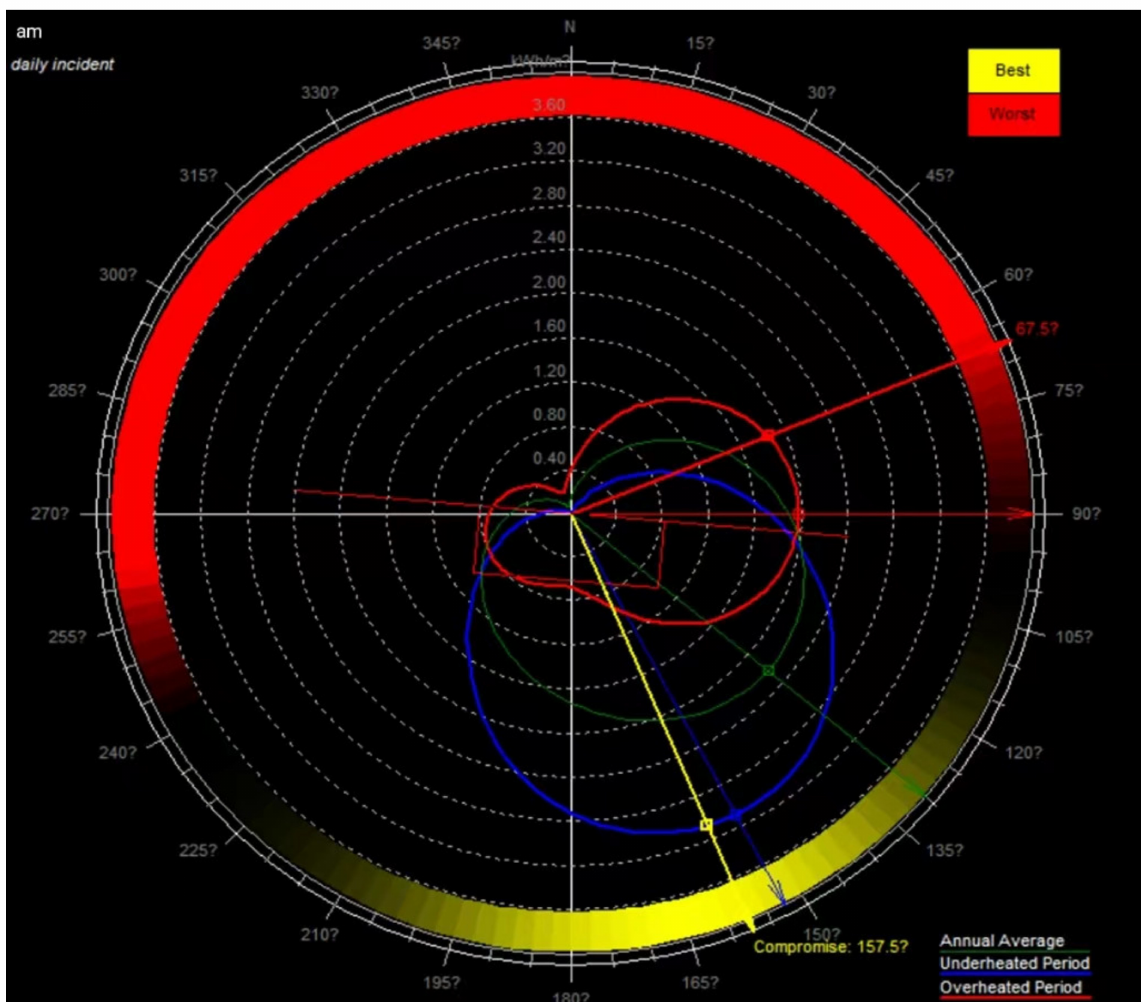
Figure 16. Optimal orientation